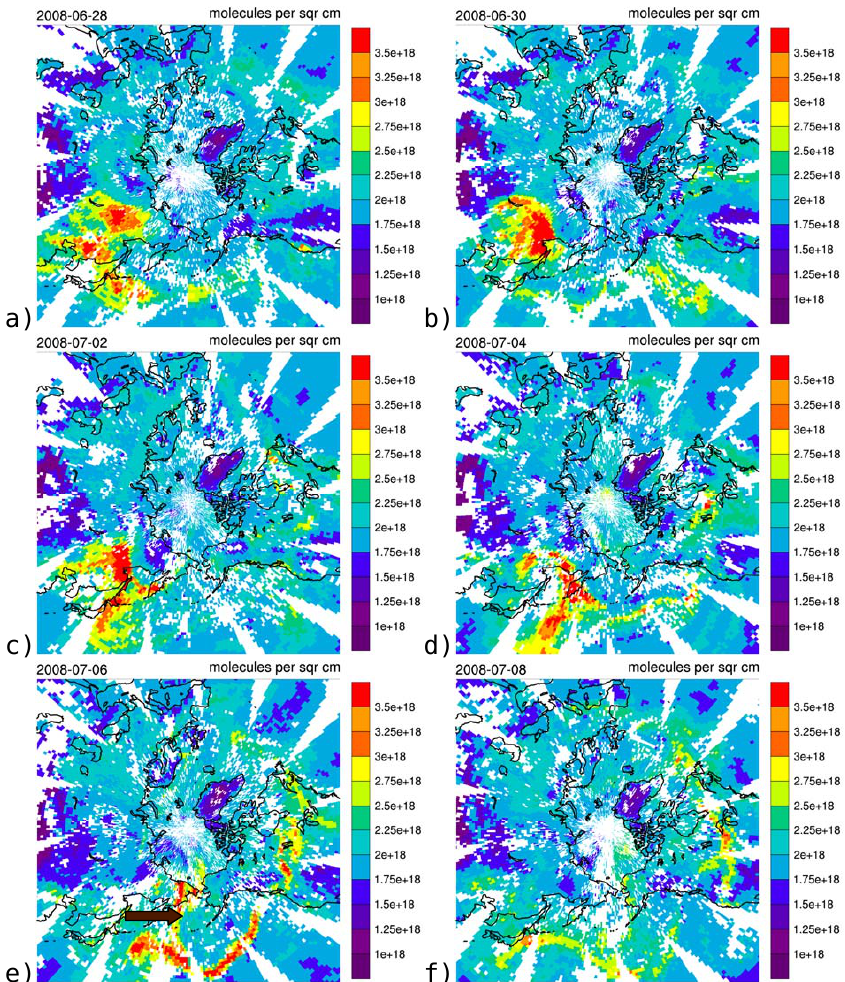
Fig. 8. AIRS 1 × 1 deg Level 3 Total Column CO (molecules cm -2 ) between 28 June - 8 July 2008. The arrow in panel e) is the second plume discussed in the Arctic long range transport section.